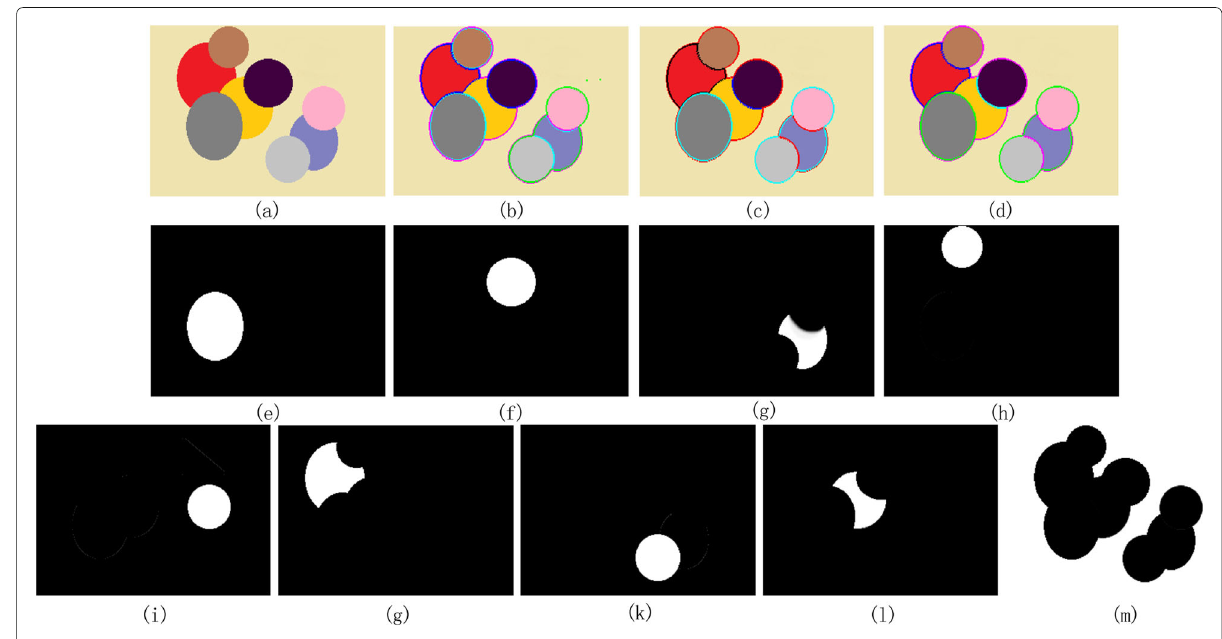
Fig. 11 Nine-phase segmentation of a color image. a The input color synthetic image. b The segmentation of original Vese-Chan method. c The segmentation of TV regularization method. d The segmentation of our model. e – m Nine meaningful regions obtained via our method parameter computations for φ , w , λ and parameter esti- mations for u , both of which are relative to the image sizes. Besides, the former one is also relative to the number of binary label function m . When there exist redundant regions in the images, (i.e., N < 2 m ), parameter estima- tions are relevant to N .